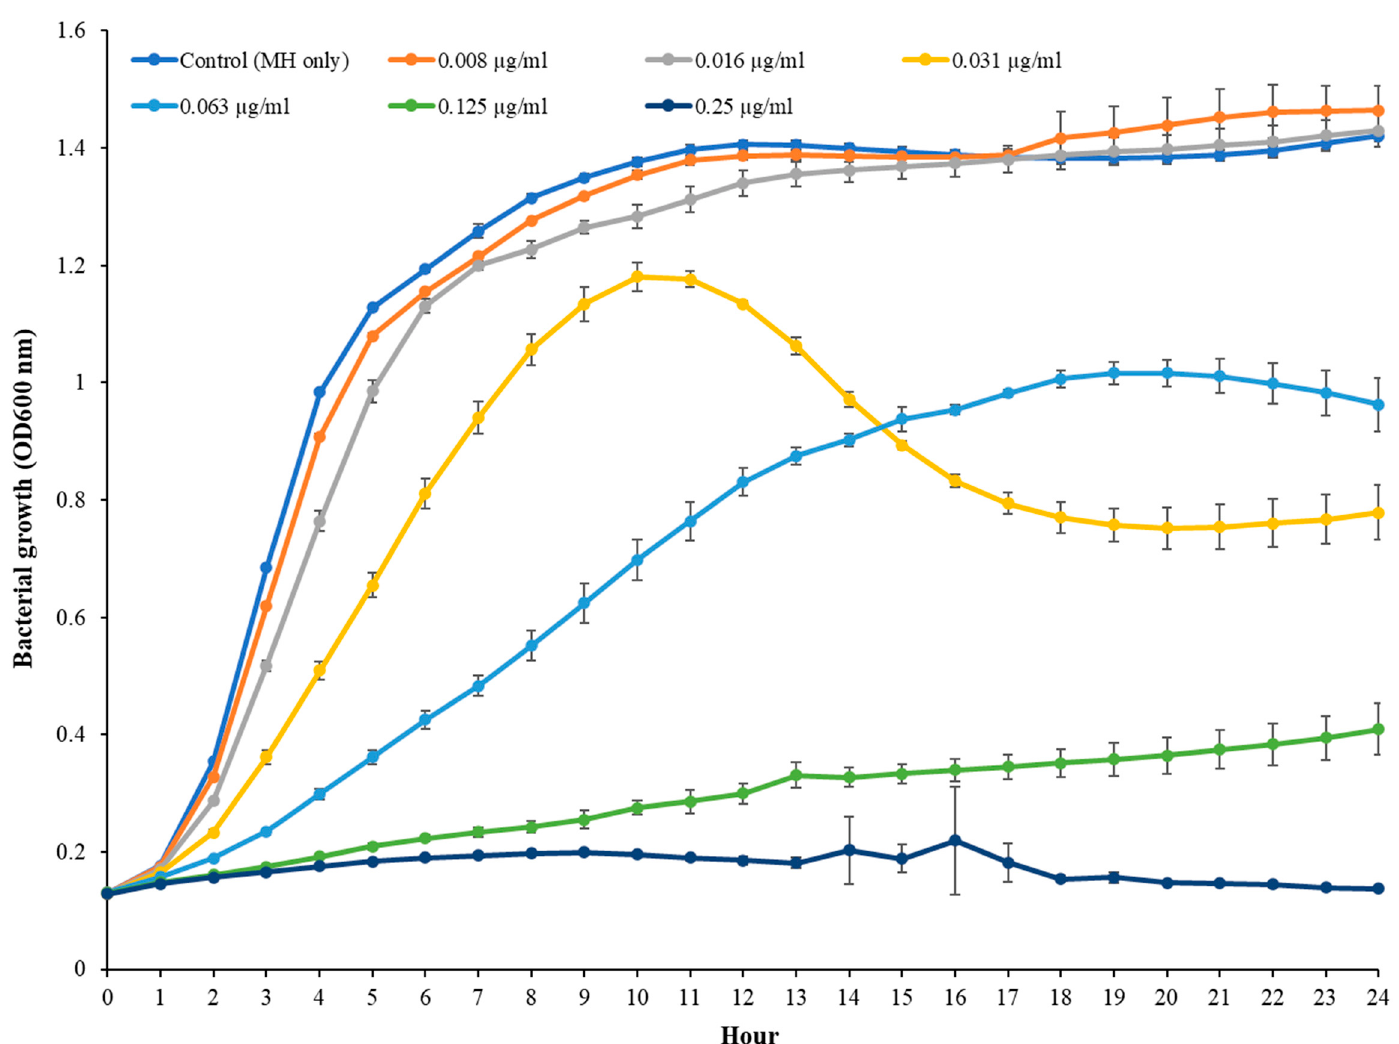
Figure 1. MIC measurement of TC in S. epidermidis RP62A.